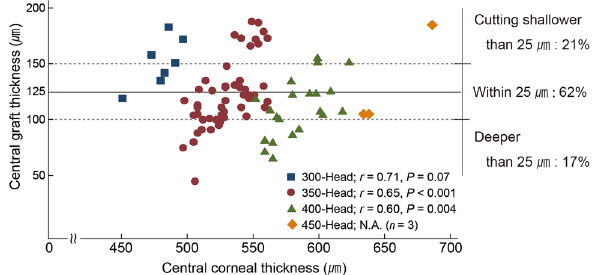
Figure 1. A scatter plot of the central donor corneal thickness versus post-cut central graft thickness by each microkeratome head size. The central donor corneal thickness and post-cut central graft thickness are positively correlated (Pearson r = 0.60 to 0.65; P < 0.01) in 350- and 400-microkeratome head sizes. Approximately 62% of the grafts could be cut within the target central graft thickness range (125 ± 25 μm); 21% of the grafts were cut to a depth shallower than 25 μm, and 17% were cut deeper. The solid line represents the target thickness (125 μm); the dashed line indicates the ± 25 μm range; and the square indicates the 300-, 350- (circle), 400- (triangle), and 450-heads